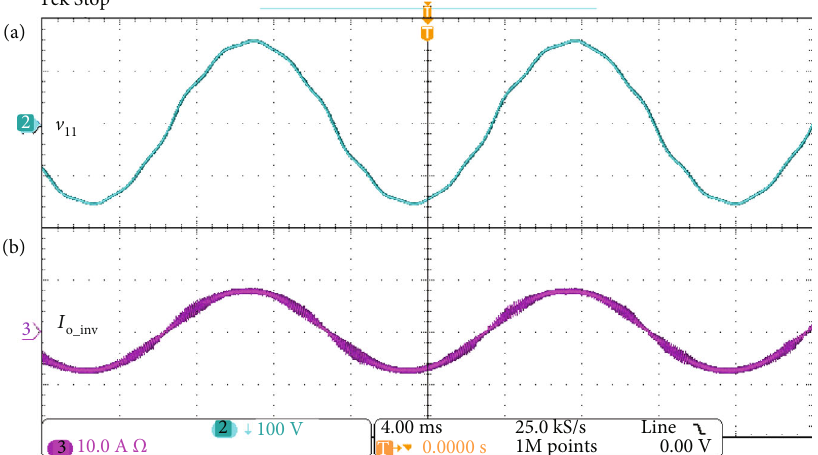
Figure 15: Grid voltage distortion test: (a) local voltage in residence 11 ( V ms/div.